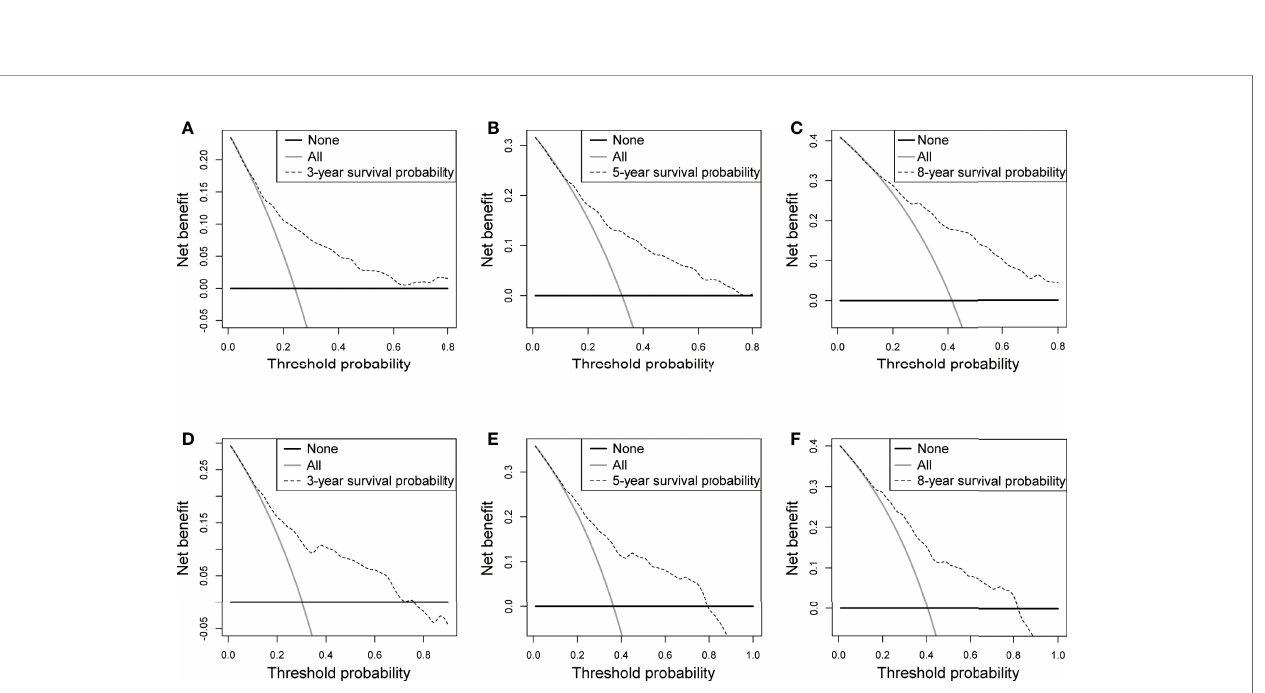
FIGURE 4 | Calibration curves of the nomogram for 3-, 5-, and 8-year OS prediction. (A-C) 3-, 5-, and 8-year OS rate in the training set; (D-F) 3-, 5-, and 8-year OS rate in the validation set.